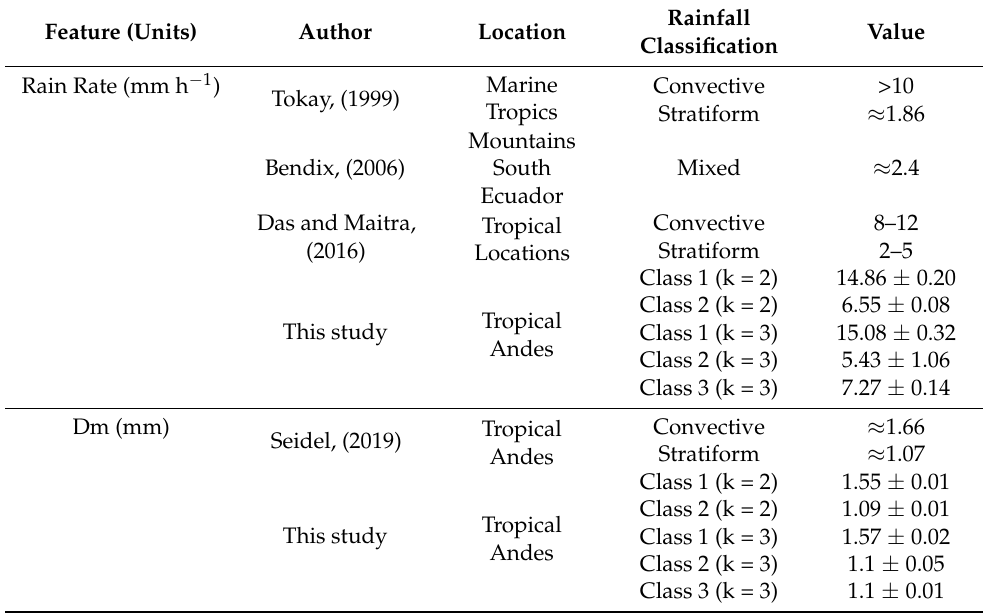
Table 2. Summary of rainfall features thresholds of Tropical